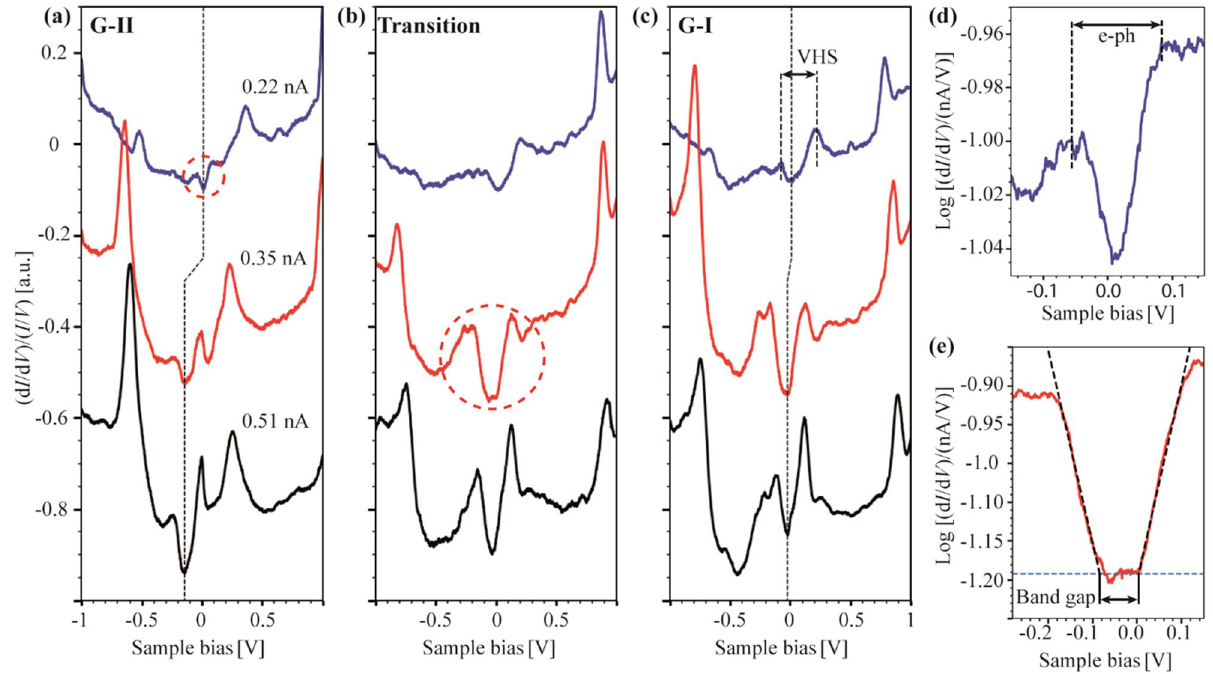
Figure 6. Normalized differential conductance measurements at three W tip—SLG/α-Al 2 O 3 (0001) distances controlled by setpoint currents (0.22 nA, 0.35 nA, and 0.51 nA corresponding to the blue, red, and black curves, respectively, at V bias = 1.0 V). ( a ) G-II region near the step edge. ( b ) Transition region between G-II and G-I. ( c ) G-I region on the sapphire terrace. A Dirac point shift as the tip is approached is indicated by the dashed vertical line. ( d ) Diagram of the Dirac cone marked in ( a ). ( e ) Plot of the substrate-induced bandgap opening marked in ( b ).